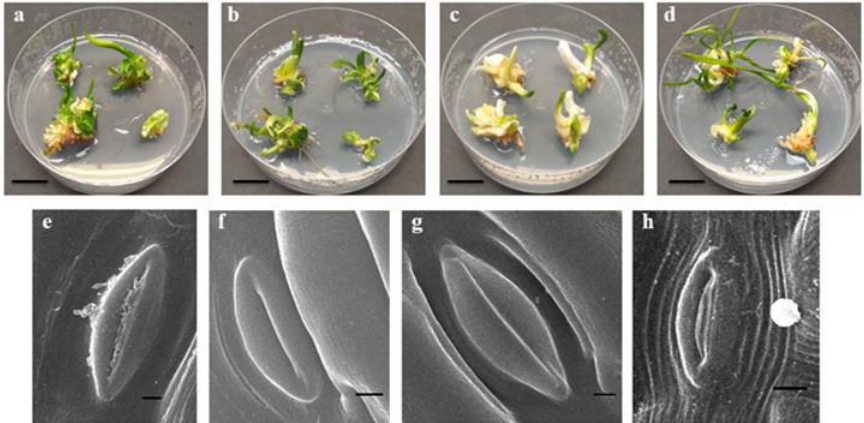
Figure 1. Growth of L. aestivum plants (bar = 2 cm), and stomata leaf (bar = 100 µm) appearance after four weeks of culturing under different light conditions: ( a , e ) white (F) (control), ( b , f ) blue (L), ( c , g ) red (L), ( d , h ) white (L)-red (L). F: fluorescence, L: LED light. The mixed white and red (1:1) LED light stimulated the greatest increase in the fresh biomass of the L. aestivum plants (0.46 g fresh weight: FW). Slightly lower values were recorded for the plant material obtained with a red LED light (0.41 g FW). The plants that grew under the blue LED and white fluorescent lights (control) showed the lowest biomass increases (0.29 g and 0.33 g FW, respectively) (Figure 2). In the Cio´c et al. [13] study, blue light, contrary to the presented research, had a positive effect on obtaining Myrtus communis shoots, characterised by the highest fresh biomass. Several studies have shown that the combination of different wavelengths of light LEDs can promote plant growth. Most often, various proportions of red and blue lights are used. Silva et al. [17] found that a mixture of red and blue lights (1:1) increased biomass accumulation in plants of Pfaffia glomerata in vitro, while Hung et al. [39] showed that a combination of 50% red and 50% blue LED lights increased shoot and root biomass of Vaccinium corymbosum plants in vitro. Using mixed light, Hassanpour [18] discovered that a mixture of red and blue lights (75%:25%) was optimal for obtaining the maximum biomass of Hyoscyamus reticulatus callus cultures. Li et al. [12] also indicated that red and blue lights (1:2) increased the biomass of Lycoris longituba seedlings. A combination of white and red LED lights is less frequently utilised. As in the current study, Simlat et al. [40] showed a positive effect of this mixed light on the fresh biomass of Stevia rebaudiana plants obtained from in vitro